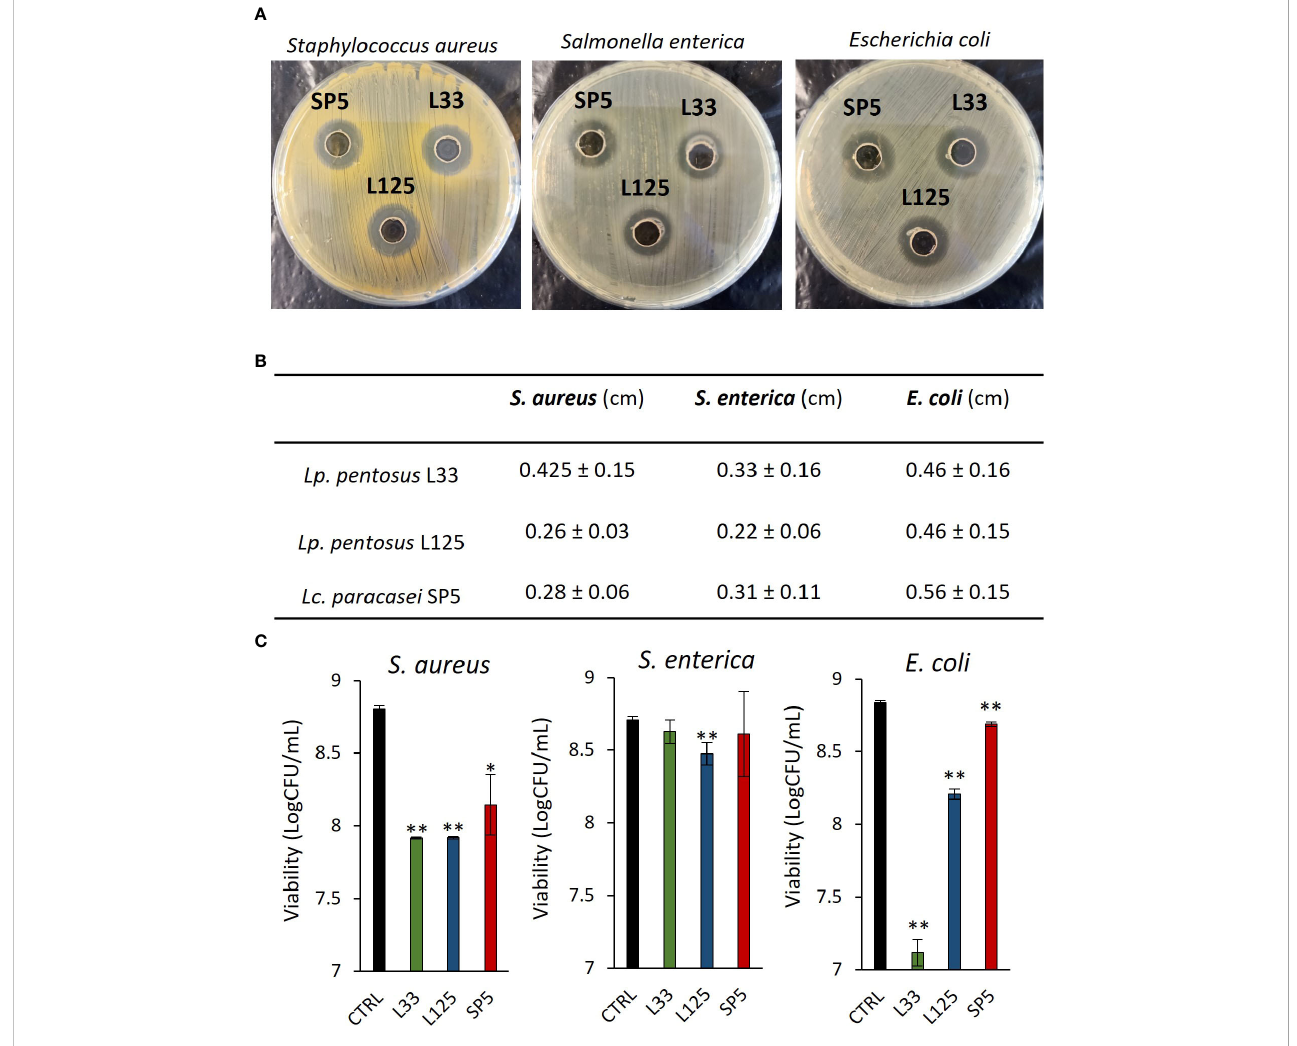
FIGURE 1 Evaluation of the antimicrobial activity of viable potential probiotic LAB strains against S. aureus, S. enterica and E . coli. (A) Representative photos of inhibition zones of fresh O/N cultures of Lp. plantarum L125, Lp. pentosus L33 and Lc. paracasei SP5 against S. aureus , S. enterica and E . coli , using the agar well diffusion assay. (B) Zone of inhibition in cm. Results are expressed as the mean ± standard deviation of three independent experiments. (C) Antimicrobial activity of viable lactobacilli against planktonic pathogens in co-culture for 24 h. Results are expressed as mean ± standard deviation of three independent experiments. * p < 0.05, ** p < 0.01, compared to control, untreated